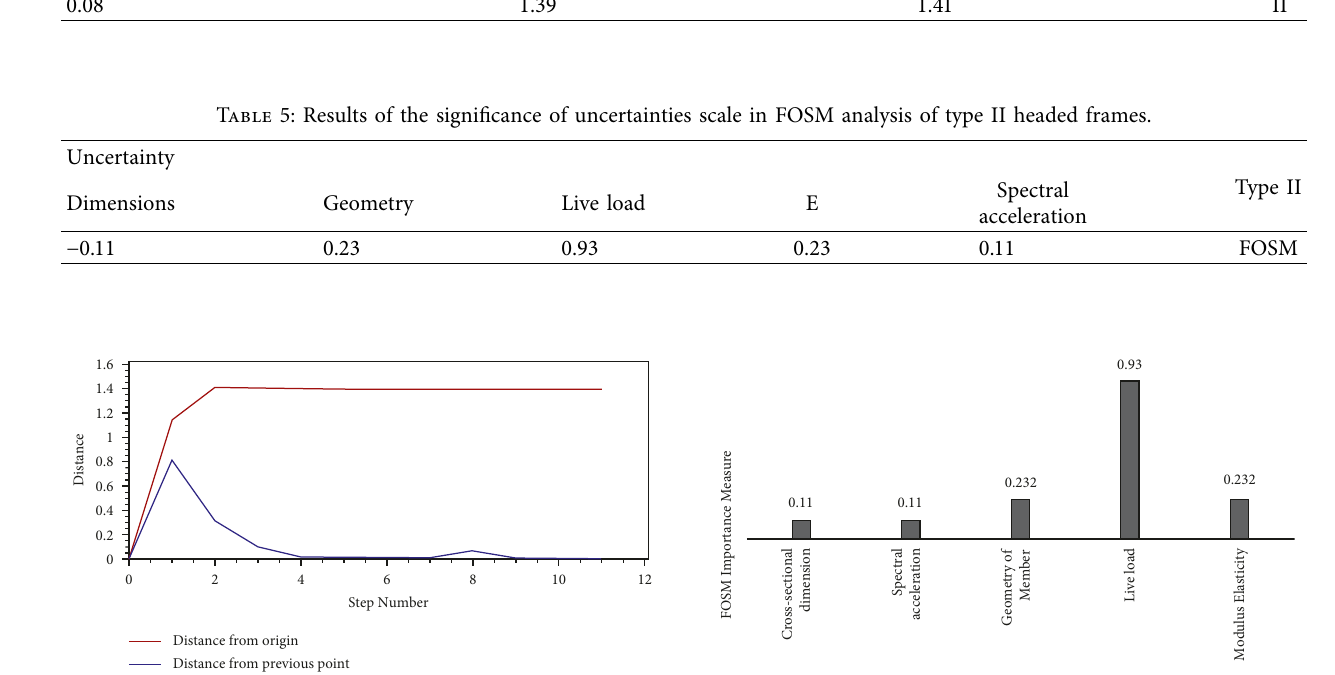
Figure 10: Scale diagram of the significance of type II frame uncertainties in the FOSM